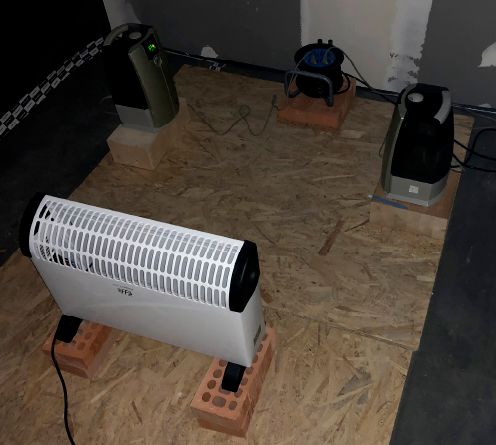
Figure 6. Hygrothermal control devices.